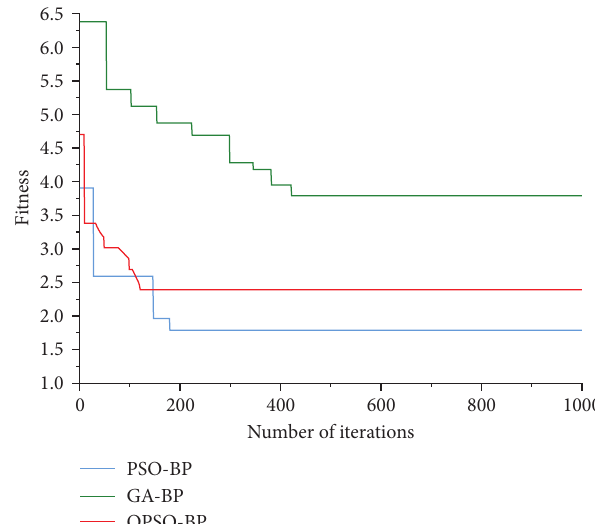
Figure 3: Convergence curves of the QPSO, GA and PSO